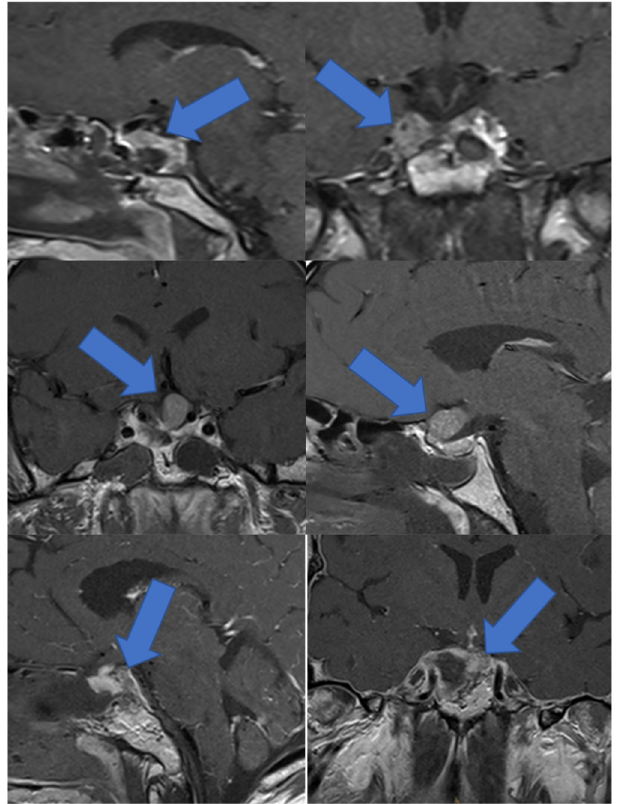
Figure 1. Pictures in the first row depict sagittal and coronal- with gadolinium-enhanced MRI, showing intracavernous tumor remnant. In the second row, tumor remnant perforating the diaphragm is depicted on coronal- and sagittal-enhanced MRI scans, and in the third row, adenoma remnant infiltrating the clivus is shown.